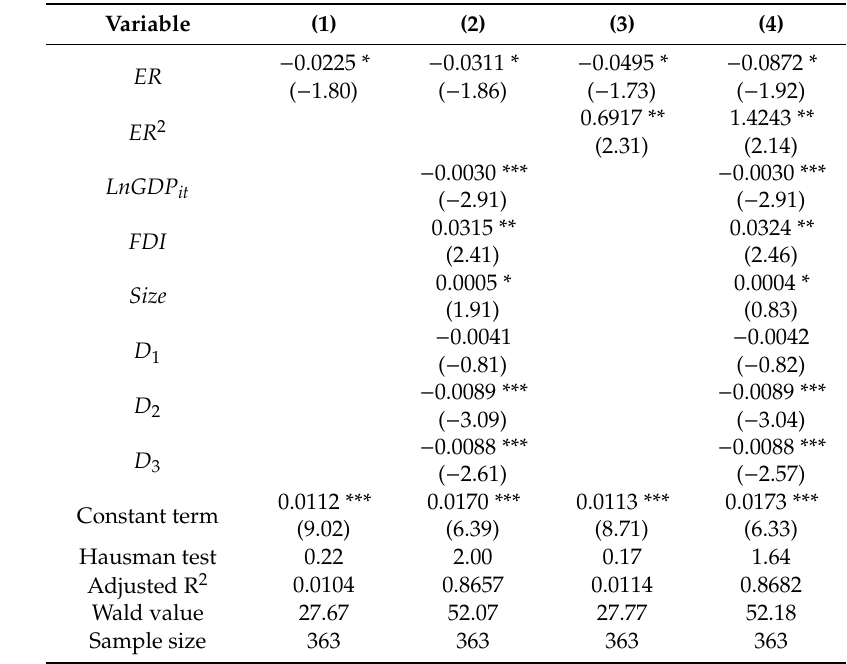
Table 2. Test result of U-shaped relation between the environmental regulation and scientific and technological competitiveness of resource-based